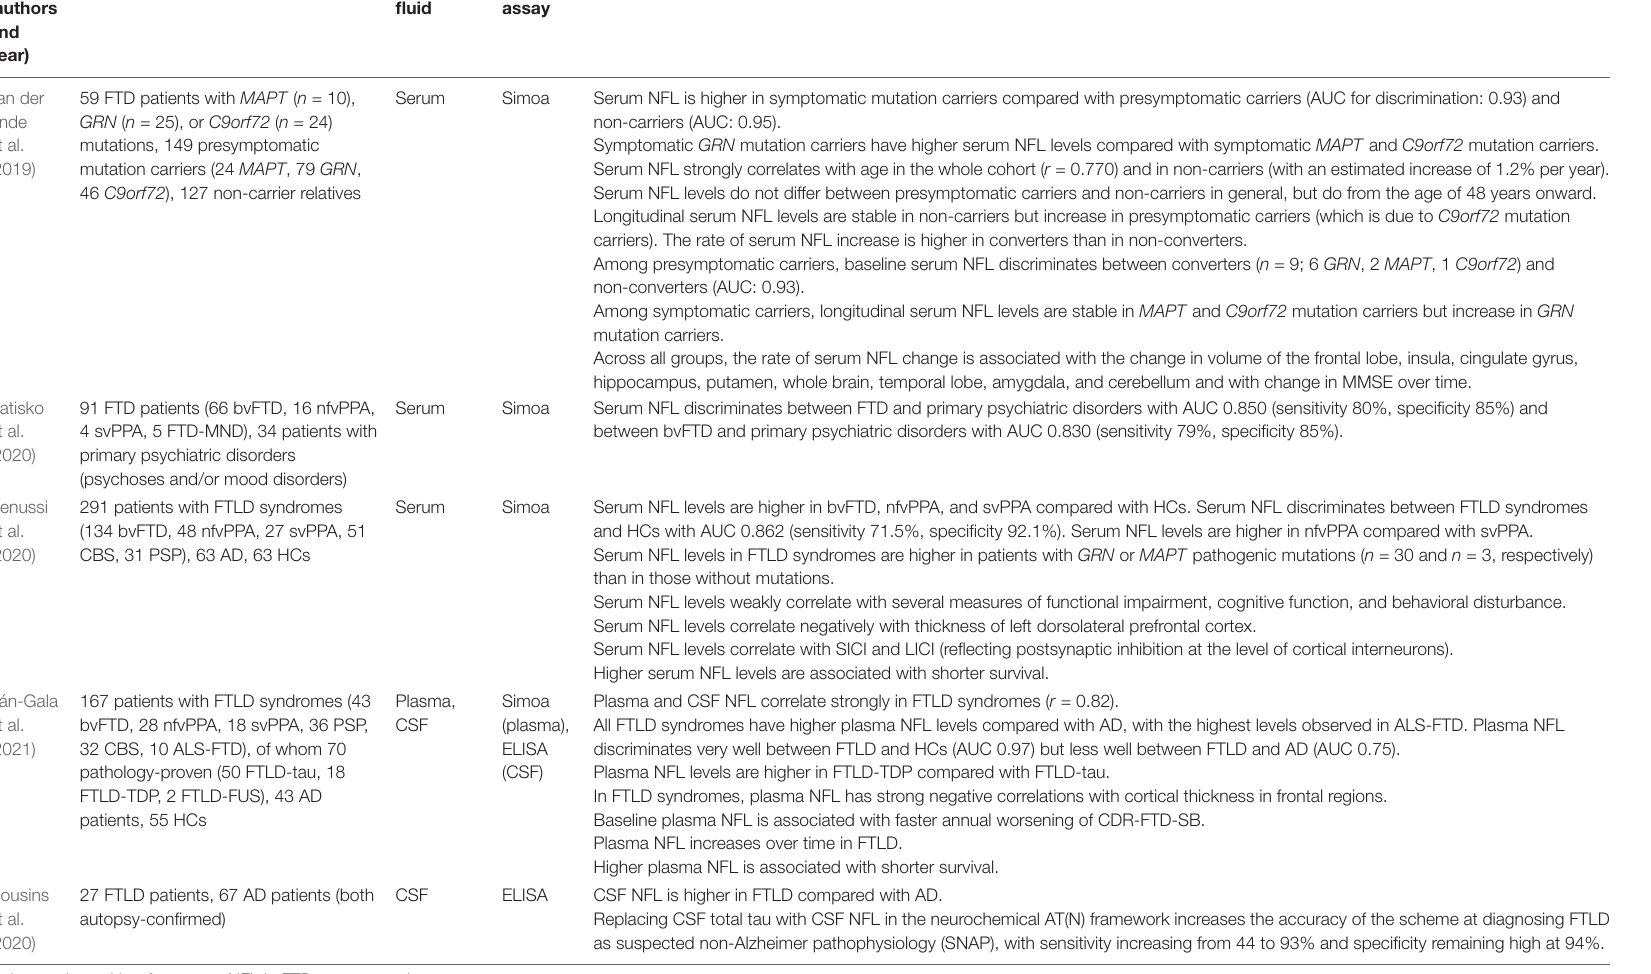
Simoa Serum NFL is higher in symptomatic mutation carriers compared with presymptomatic carriers (AUC for discrimination: 0.93) and non-carriers (AUC: 0.95). Symptomatic GRN mutation carriers have higher serum NFL levels compared with symptomatic MAPT and C9orf72 mutation carriers. Serum NFL strongly correlates with age in the whole cohort ( r = 0.770) and in non-carriers (with an estimated increase of 1.2% per year). Serum NFL levels do not differ between presymptomatic carriers and non-carriers in general, but do from the age of 48 years onward. Longitudinal serum NFL levels are stable in non-carriers but increase in presymptomatic carriers (which is due to C9orf72 mutation carriers). The rate of serum NFL increase is higher in converters than in non-converters. Among presymptomatic carriers, baseline serum NFL discriminates between converters ( n = 9; 6 GRN , 2 MAPT , 1 C9orf72 ) and non-converters (AUC: 0.93). Among symptomatic carriers, longitudinal serum NFL levels are stable in MAPT and C9orf72 mutation carriers but increase in GRN mutation carriers. Across all groups, the rate of serum NFL change is associated with the change in volume of the frontal lobe, insula, cingulate gyrus, hippocampus, putamen, whole brain, temporal lobe, amygdala, and cerebellum and with change in MMSE over time. Serum Simoa Serum NFL discriminates between FTD and primary psychiatric disorders with AUC 0.850 (sensitivity 80%, specificity 85%) and between bvFTD and primary psychiatric disorders with AUC 0.830 (sensitivity 79%, specificity 85%).